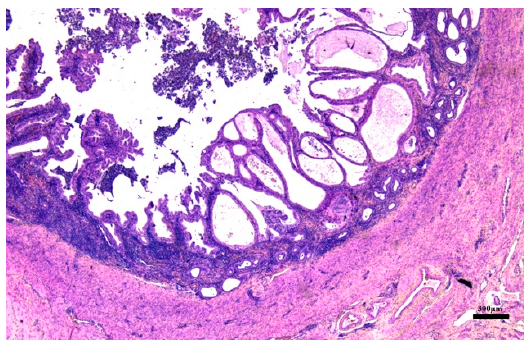
Figure 4. Uterus: endometrial hyperplasia–pyometra complex. Evidence of numerous cysts containing purulent material, vascular congestion and focal hemorrhage. Increased endometrial thickness and number of endometrial glands, some of these ulcerated and necrotic. (H&E, 2.5×).